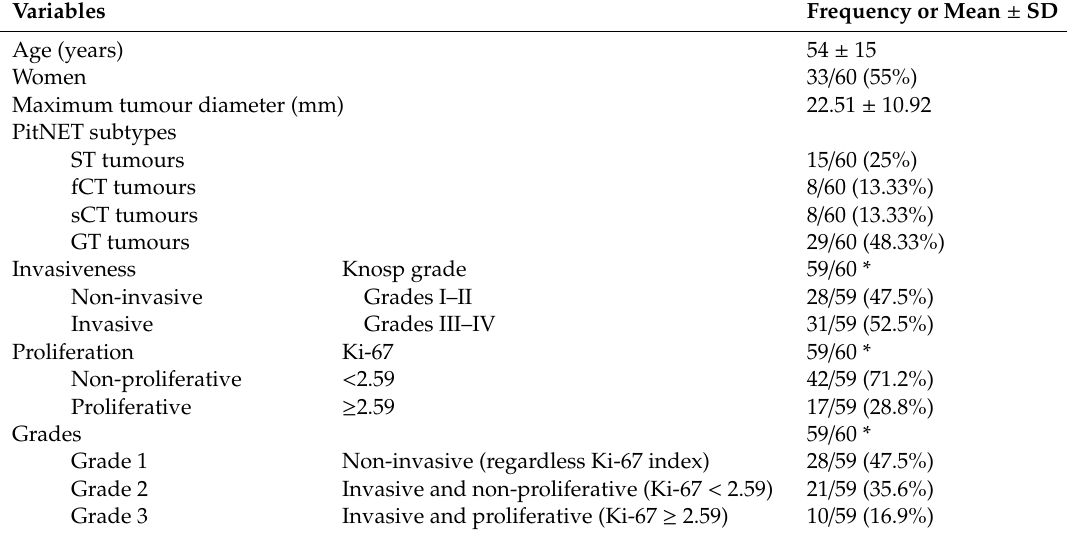
Table 2. Baseline characteristics of included patients with pituitary neuroendocrine tumours (PitNETs) ( N =